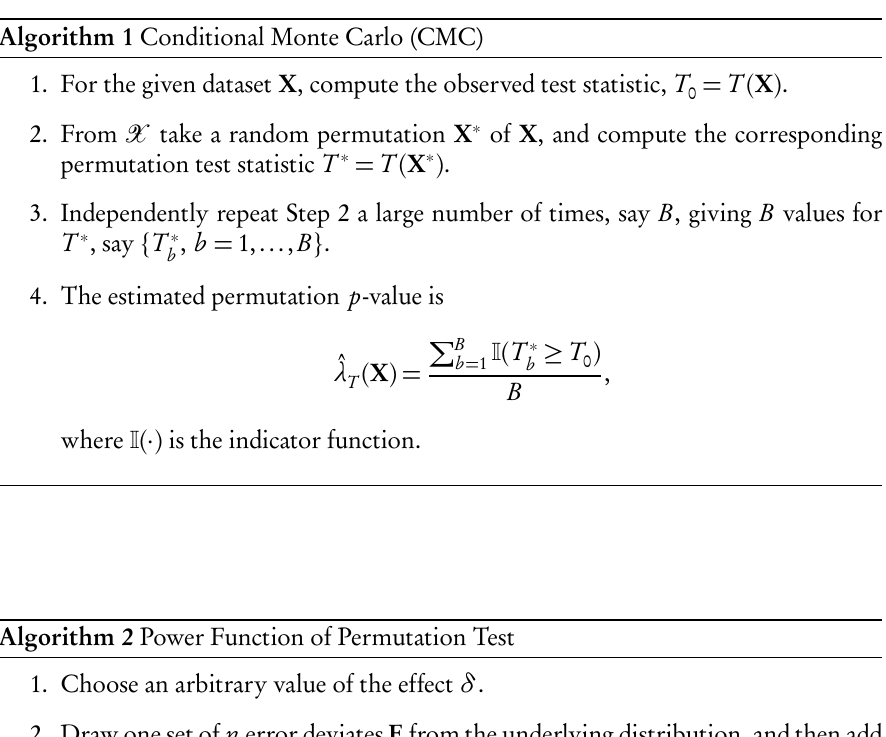
Algorithm 1 Conditional Monte Carlo (CMC)